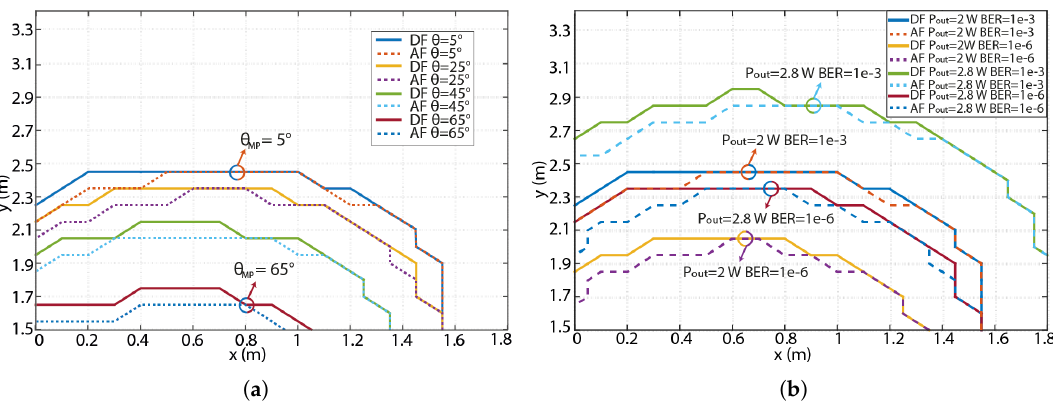
Figure 8. ( a ) Elevation angle dependence of RN for both AF and DF-based links for a range of irradiance angle θ MP , an azimuth angle of –20 ◦ and a BER of < 10 –3 ; and ( b ) RN transmitted power and the BER profiles for both DF and AF-based